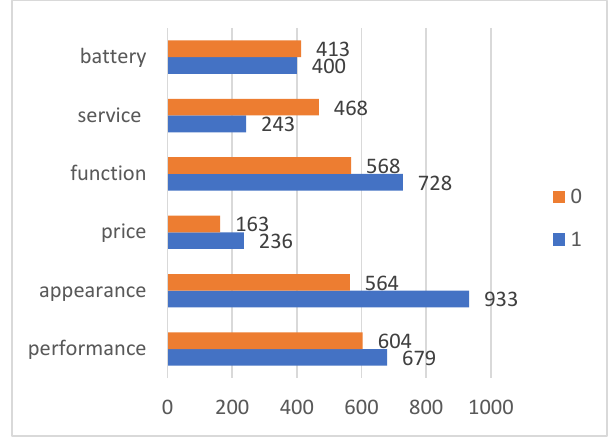
Figure 5. Length Distribution of Comment Text